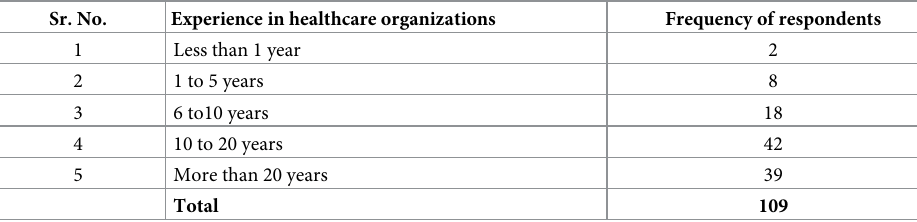
Table 2. Respondent’s experience in healthcare organizations. Sr. No.